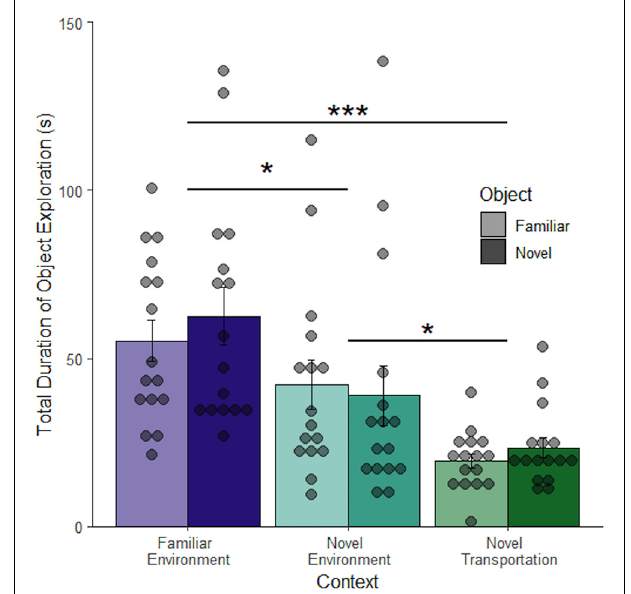
FIGURE 4 | Transportation but not object effects are retained in a novel environment. When the retention period was extended to 24 h there was no difference between mean exploration of a familiar compared to a novel object. Novel transportation to a novel environment leads to a decrease in mean object exploration, and therefore an increase in context exploration. There was a slight difference in exploration in familiar and novel environments proceeded by familiar transportation cues ( n = 96). Error bars report SEM for each group. Points indicate the total duration of object exploration for each subject grouped into bins of 4.6 s. *** p < 0.001, * p <